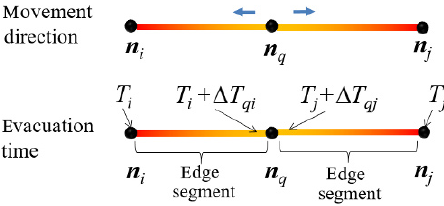
Fig. 3 Evacuation time of agents along an edge divided into two parts at a division point q . The agents are divided into two groups which move in opposite